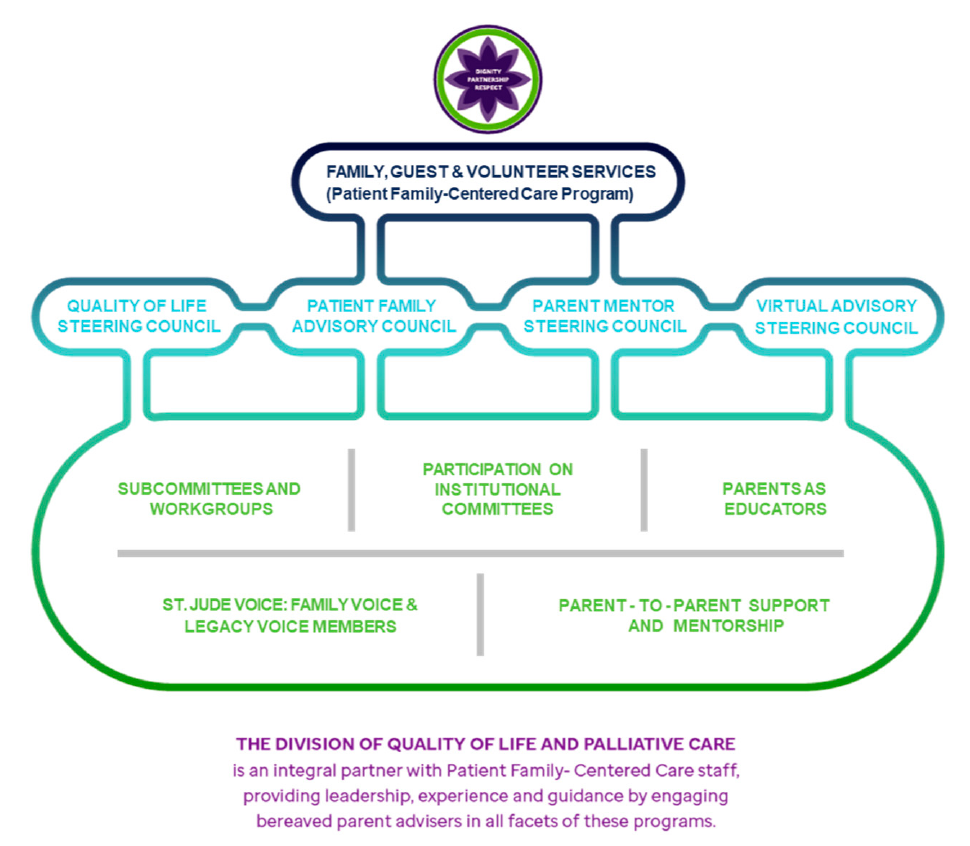
Figure 1. Quality of Life Steering Council (QoLSC) is part of the Patient- and Family-Centered Care Pro- gram.